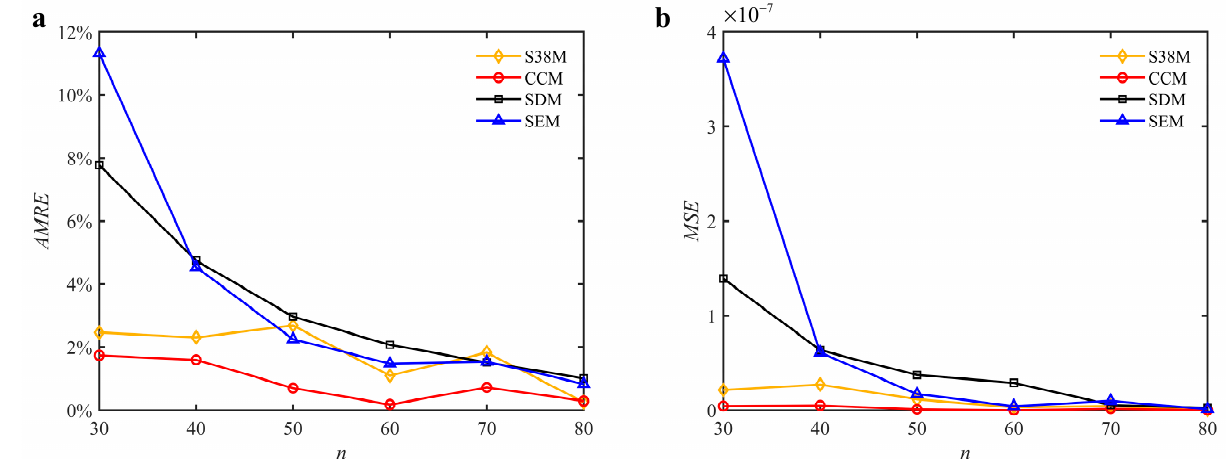
Figure 12. AMRE and MSE of the S38M for the fluctuation analysis when a / D = 0.05. ( a ) AMRE ; ( b ) MSE.